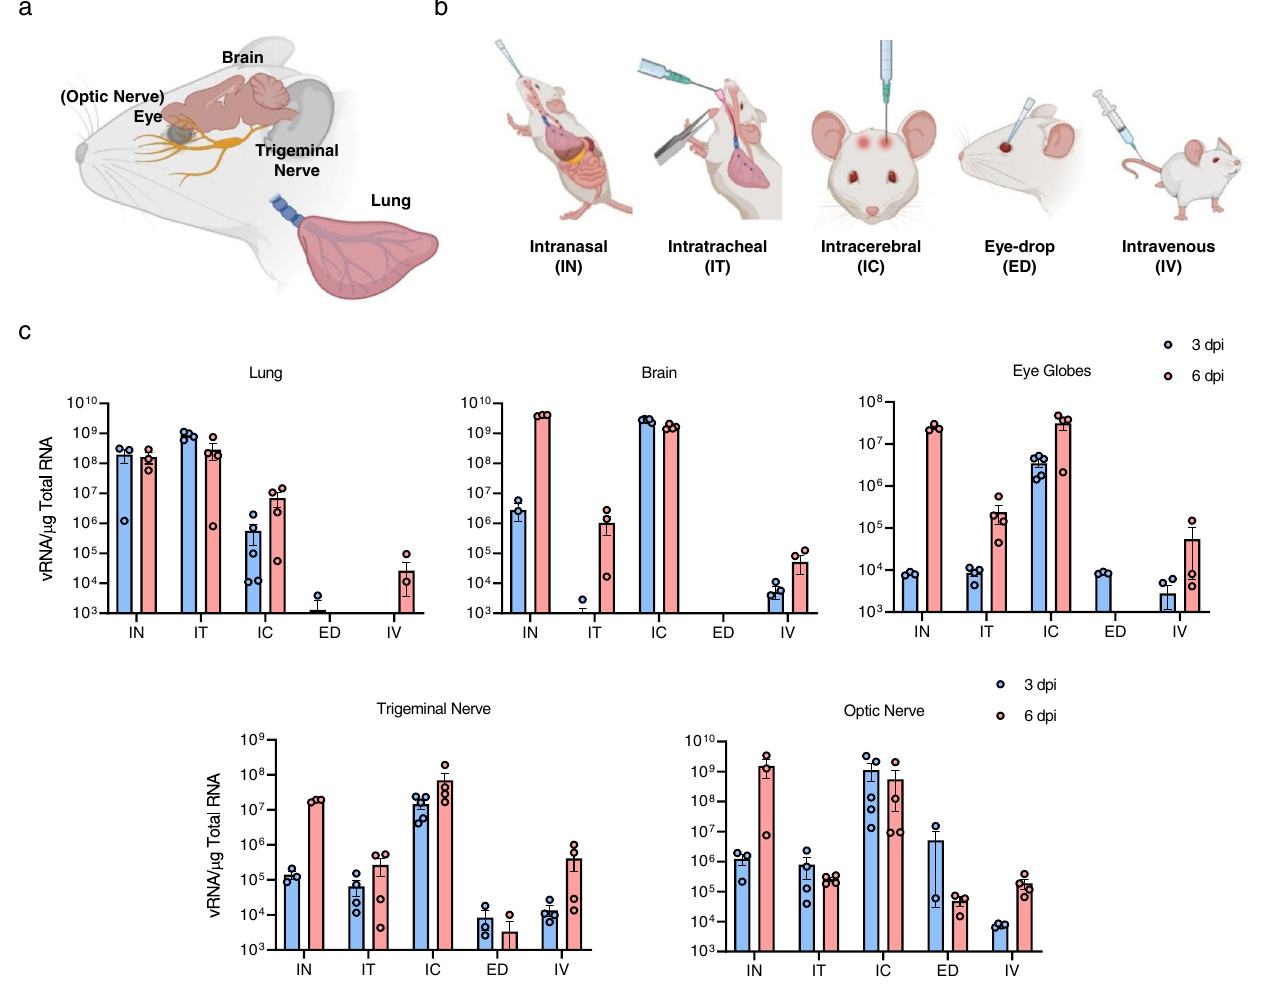
Fig. 4 | Virus titres of SARS-CoV-2-infected mice via diverse injection routes. a An anatomical graphic depicting the murine brain, eye (optic nerve), trigeminal nerve and lung. Created with BioRender.com. b Illustration showing the diverse injection routes: intranasal(IN), intratracheal (IT), intracerebral (IC), eye-drop (ED) and intravenous (IV) routes. Created with BioRender.com. c K18-hACE2 mice were inoculated with 10 4 PFU SARS-CoV-2 via fi ve different injection routes ( n =8 per